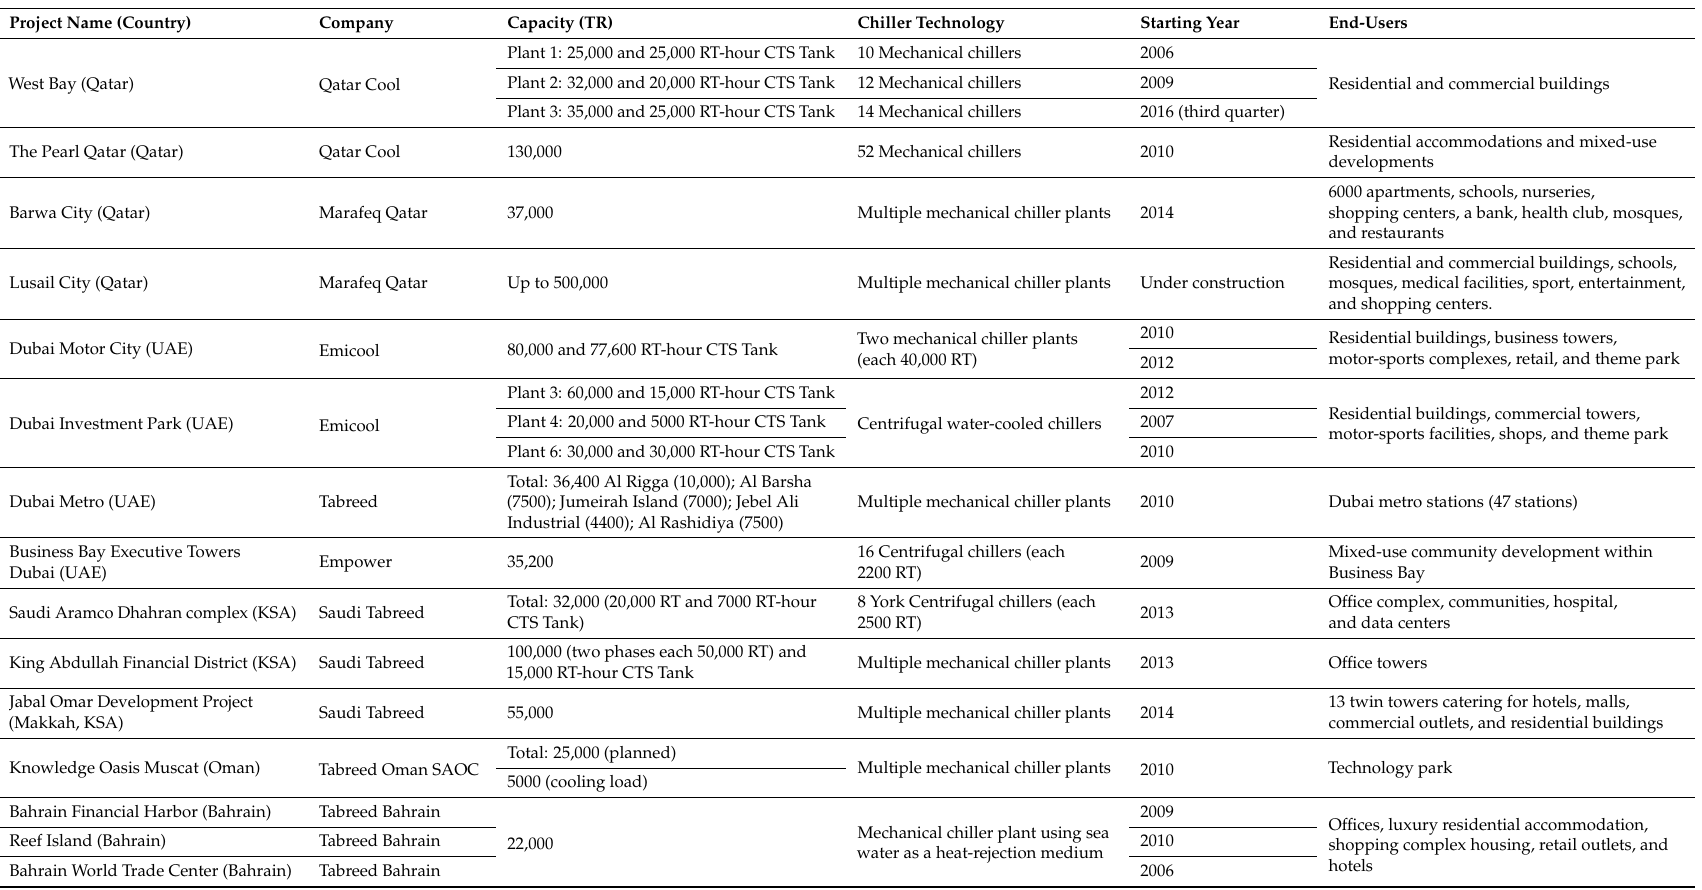
Table A5. Large-scale (i.e., capacity > 10,000 RT) DC projects in operation or under development in the GCC